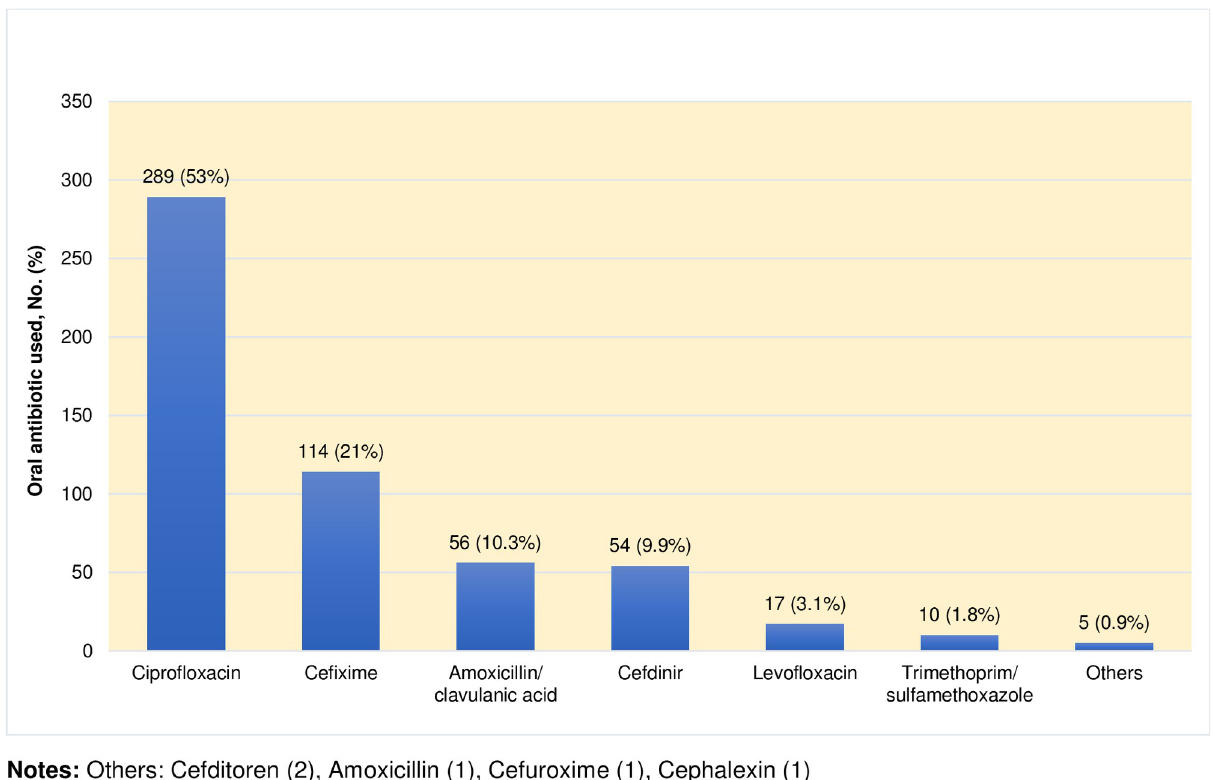
Fig 2. Oral antibiotic agents used in patients in the intravenous to oral antibiotic transition group (n = 545).